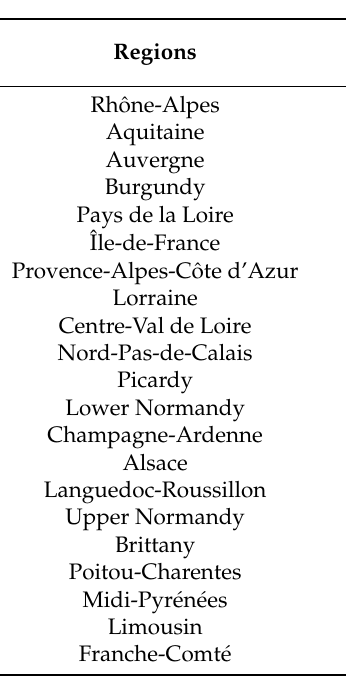
Table 2. Statistics of the regional